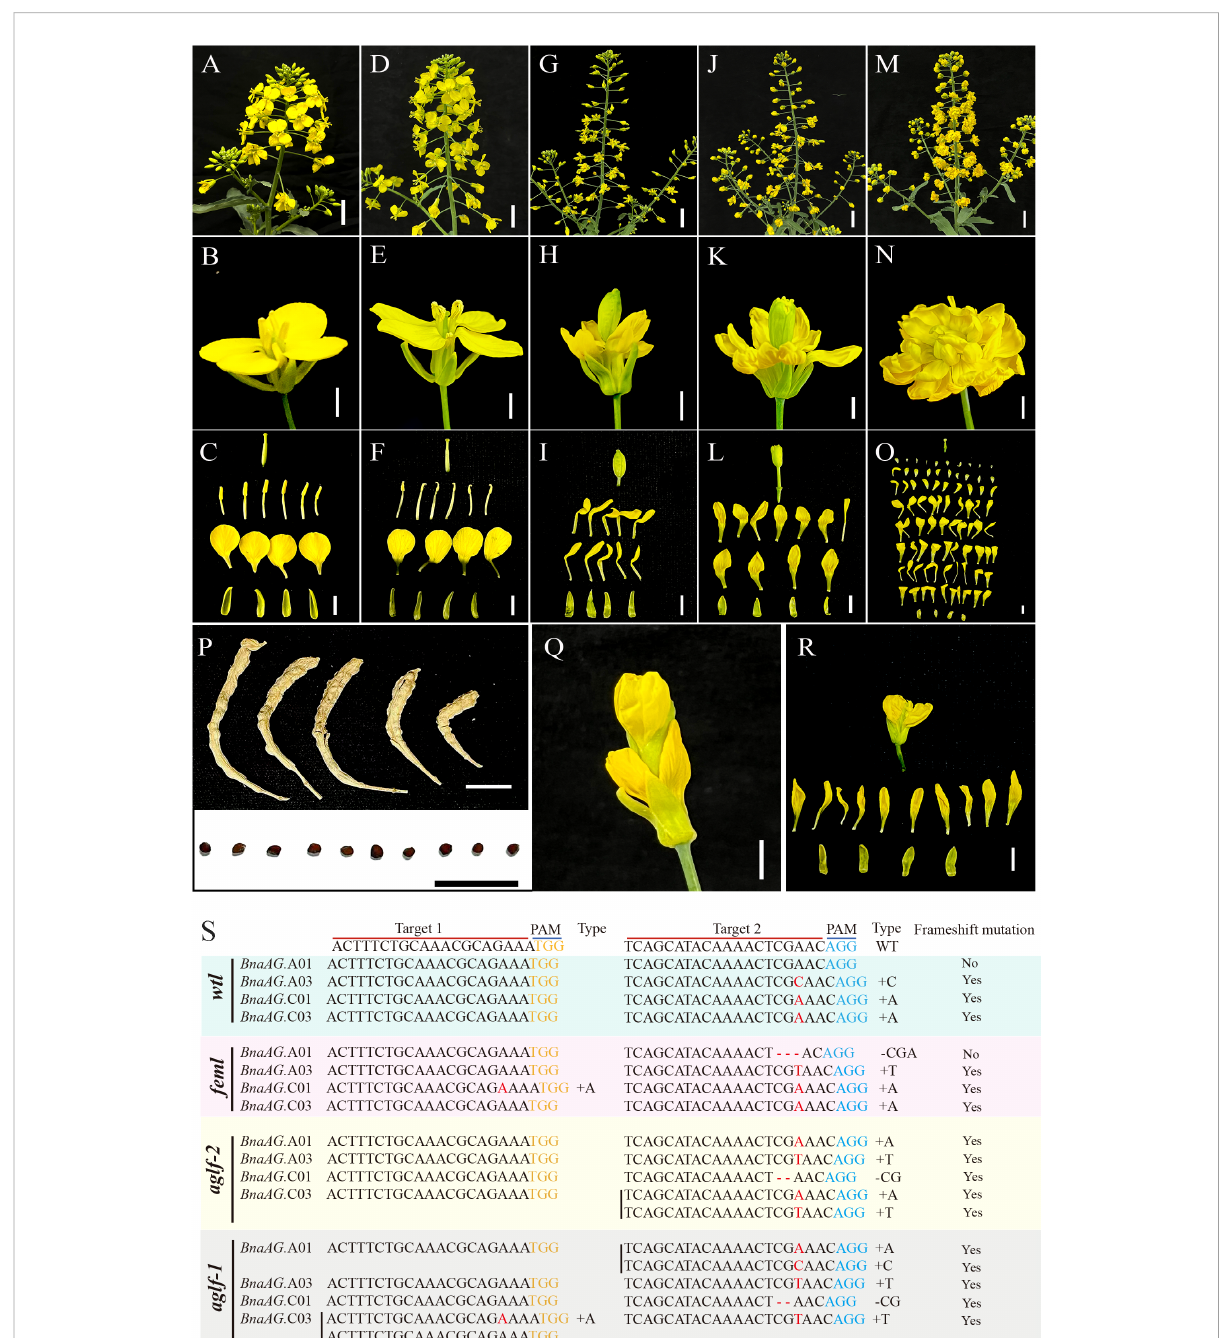
FIGURE 8 Phenotype and target sequence validation of the T0 generation of the gene-edited BnaAG genes. mIn fl orescences of WT (A) , wtl (D) , feml (G) , aglf-2 (J) , and aglf-1 (M) . Scale bars, 3 cm. The fl owers of WT (B) , wtl (E) , feml (H) , aglf-2 (K) , and aglf-1 (N) plants. Scale bars, 0.5 cm. Components from the anatomizing fl owers of WT (C) , wtl (F) , feml (I) , aglf-2 (L) , and aglf-1 (O) . Scale bars, 0.5 cm. (P) Mature siliques and seeds of feml lines after cross-pollination. Scale bars, 1 cm. (Q, R) Flower (Q) and components from the anatomizing fl ower (R) of aglf-2 during the fl owering stage. (S) Validation of target sequences for various mutant phenotypes. Yellow and blue fonts represent the PAM of target sequences 1 and 2, respectively. Red ‘ - ’ means deletions, and red font represents single base insertions. Yes or no indicates that the BnaAG gene underwent a frameshift